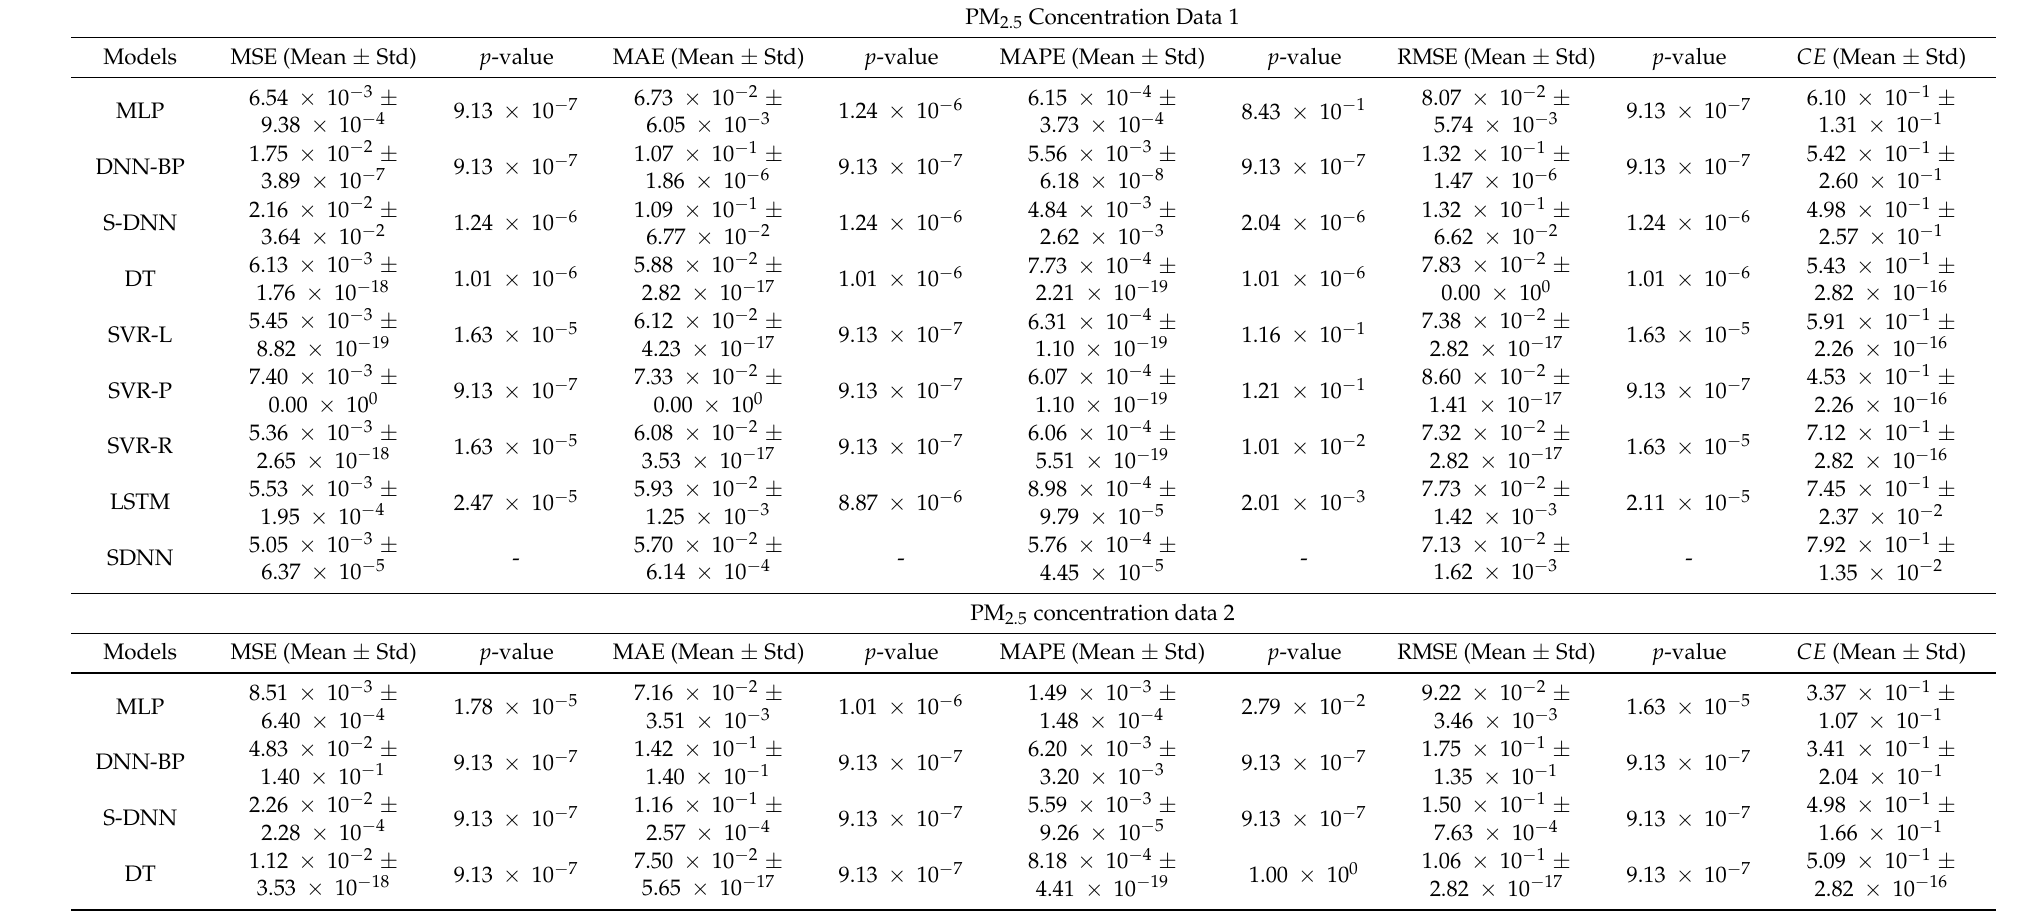
Table 8. Prediction performances of all the models for PM 2.5 concentration time series datasets